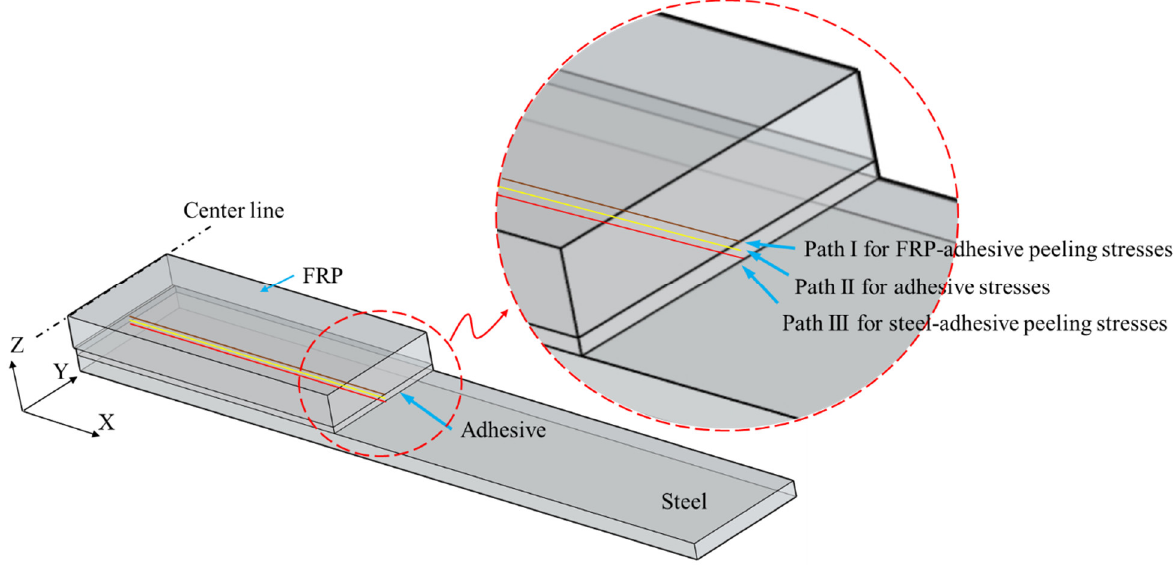
Figure 5. Paths for calculated adhesive stresses.